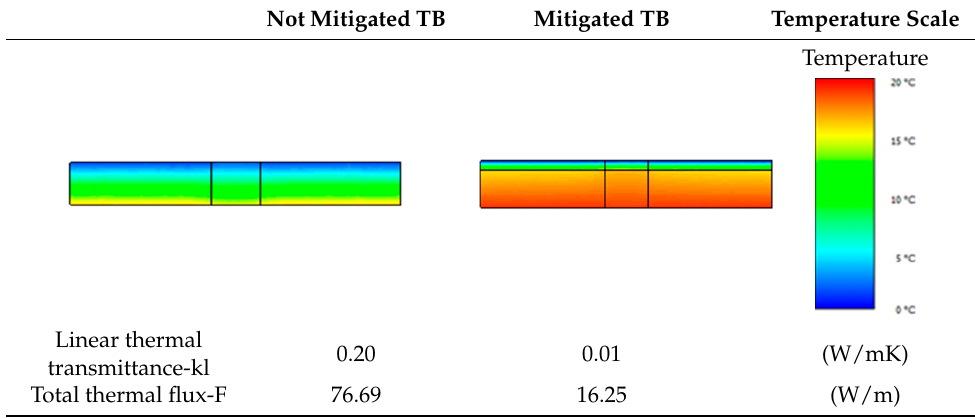
Table 14. P Thermal bridges.